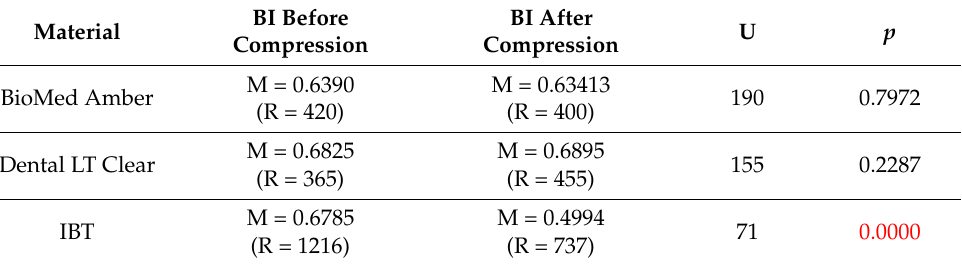
Table 17. Results of Mann–Whitney U test for comparison TA (bone index) of the examined surfaces before and after the compression test (M—mean; R—sum of ranks; U—value of Mann–Whitney U test; p — p value, underlined p < 0.05).